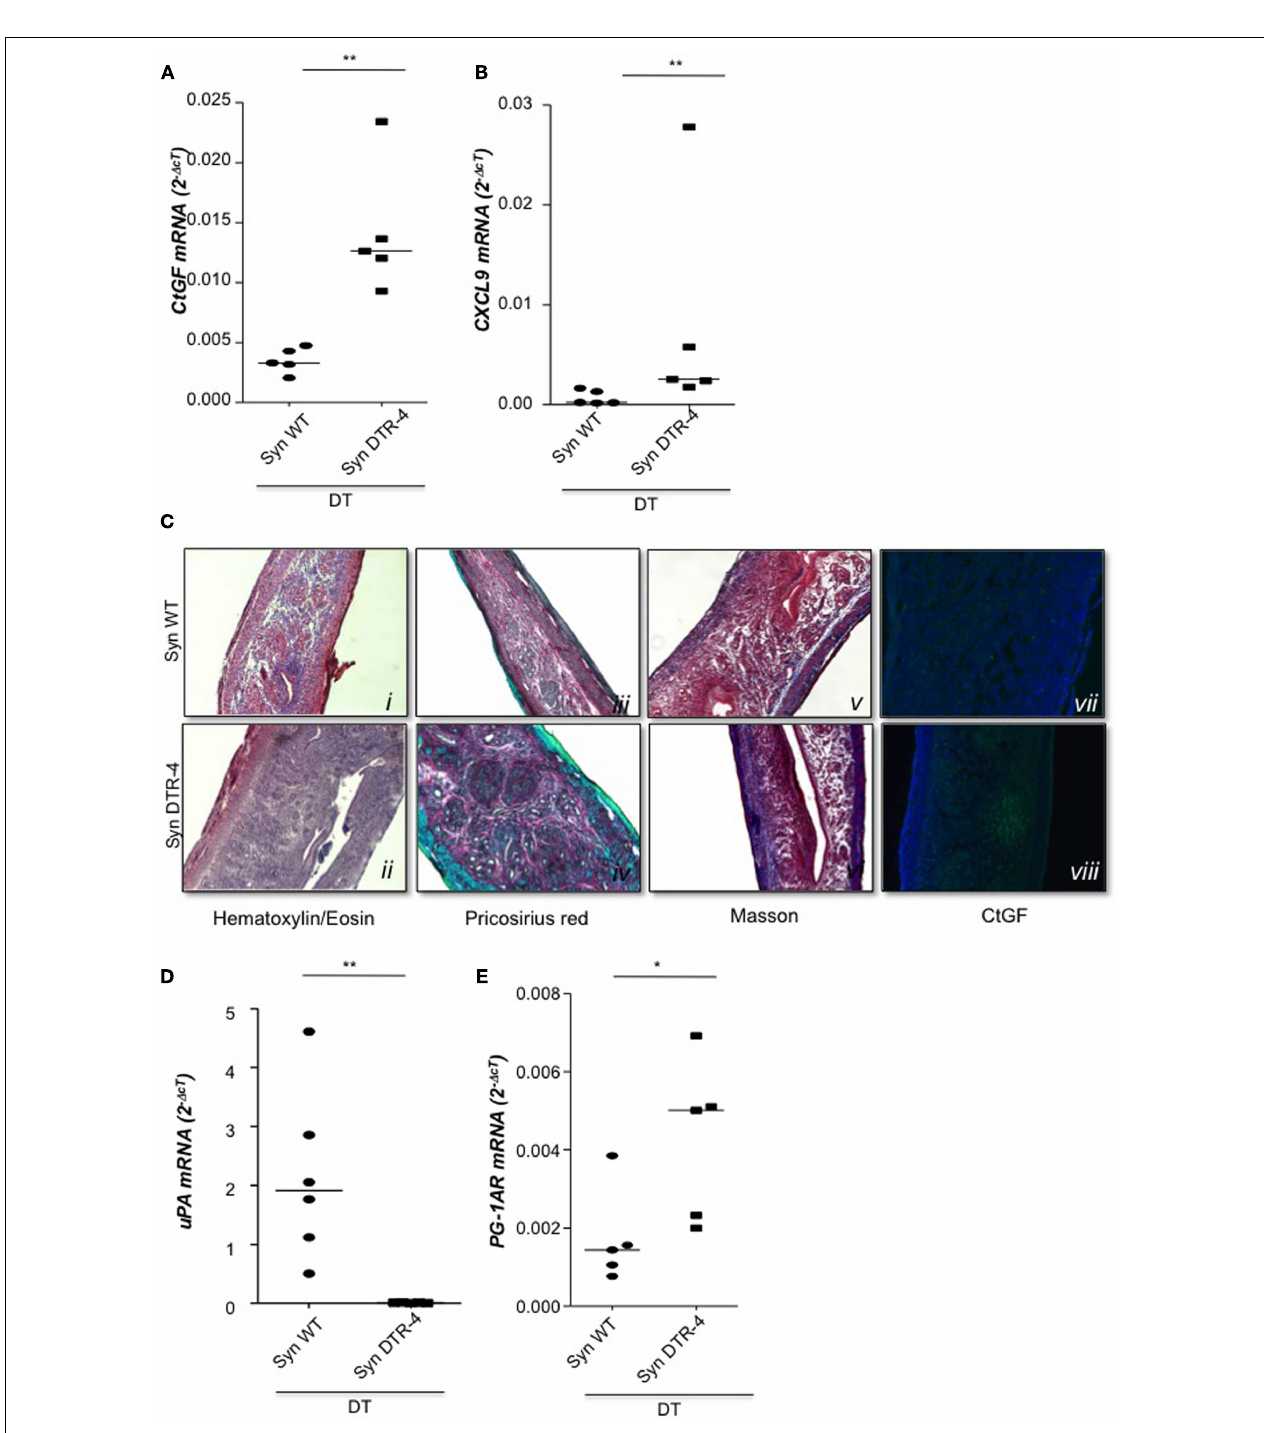
thin collagen fibers that confirms fibrosis in mice devoid ofTregs vs. controls ( C iv vs. iii ). Further, Masson’s staining manifested larger areas of collagen fibers in blue/violet in DT-treated Foxp3.Luci.DTR animals compared to DT-treated controls ( C vi vs. v ). Finally in ( C vii, viii ), immunofluorescence staining for CtGF confirmed accumulation of CtGF positive cells in mice depleted inTregs as compared to the controls. All pictures were taken with a 10 × objective. Analysis of uPA mRNA revealed that animals depleted inTregs presented very low, almost undetectable levels of this molecule as compared to DT-treated controls (D) .Treg depletion further provoked an augmentation of prostaglandin 1A mRNA (E)